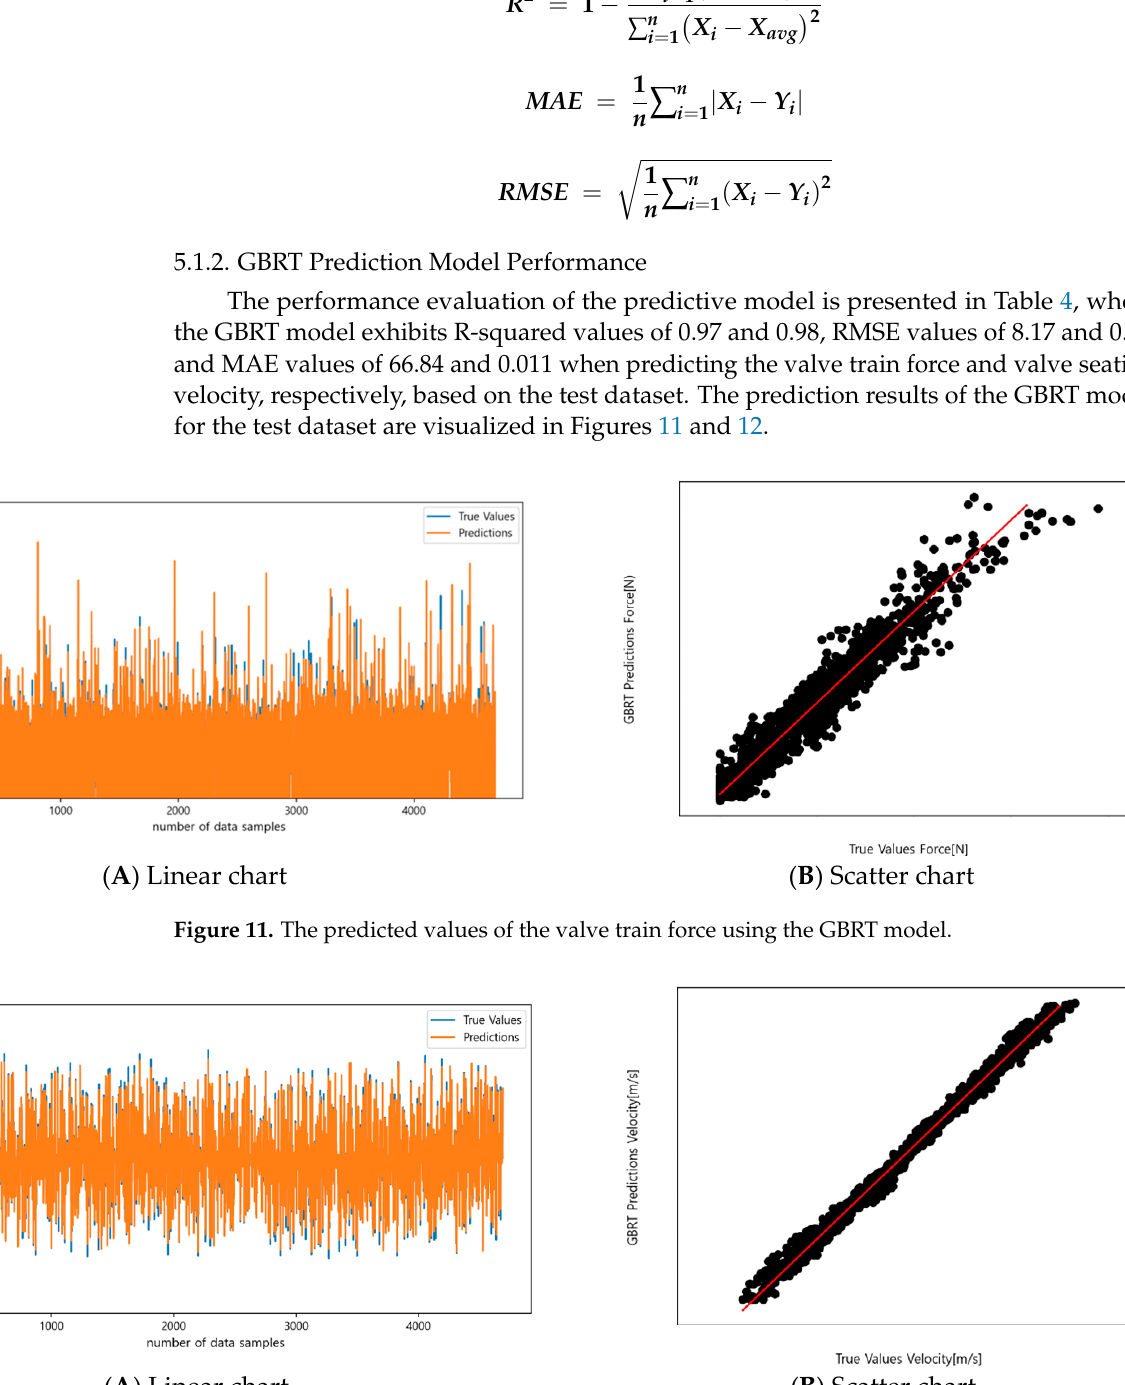
Figure 12. The predicted values of the valve seating velocity using the GBRT model. Table 4. The performance evaluation results of the GBRT prediction model.